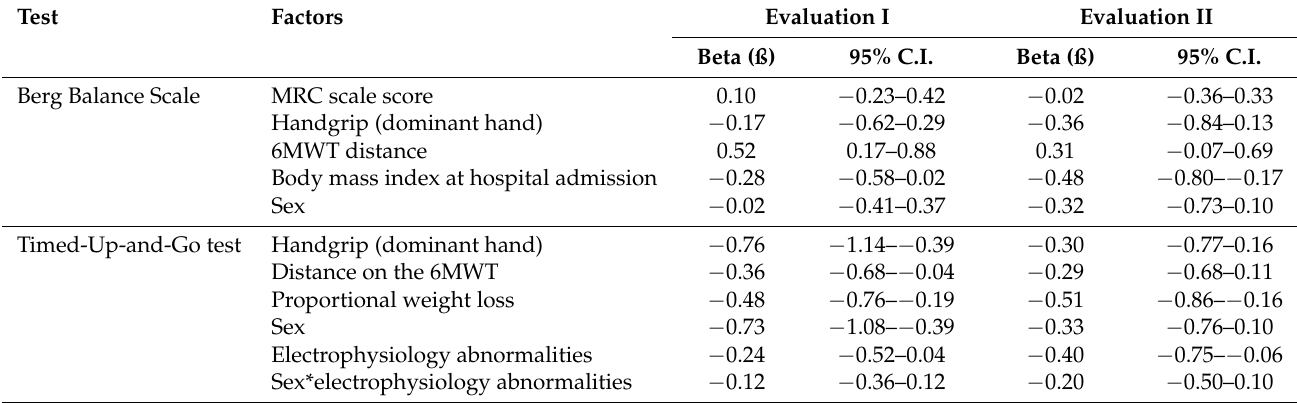
Table 6. Beta values and 95% C.I. of the beta values of the variables included in the general linear model on the time to perform the Timed-Up-and-Go test and the score on the Berg Balance